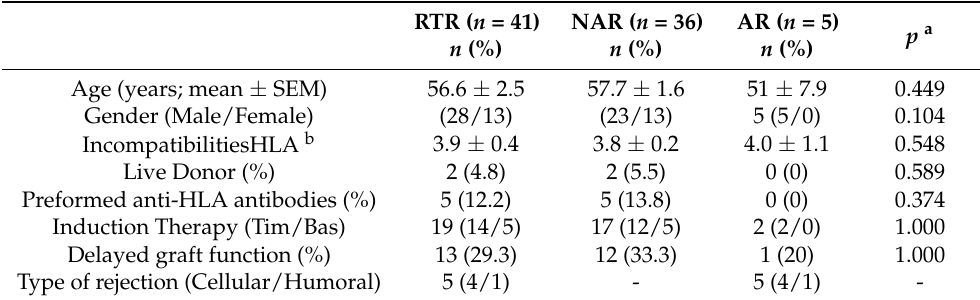
Figure 1. Flow chart of the design and study populations. Abbreviations: AR, Acute rejection; KT, Kid- ney Transplantation; NAR, Non-acute rejection; PTX, Posttransplant; RTR, Renal Transplant Recipients. Table 2. Demographic data and clinical characteristics of the transplanted patients included in the B lymphocyte monitoring